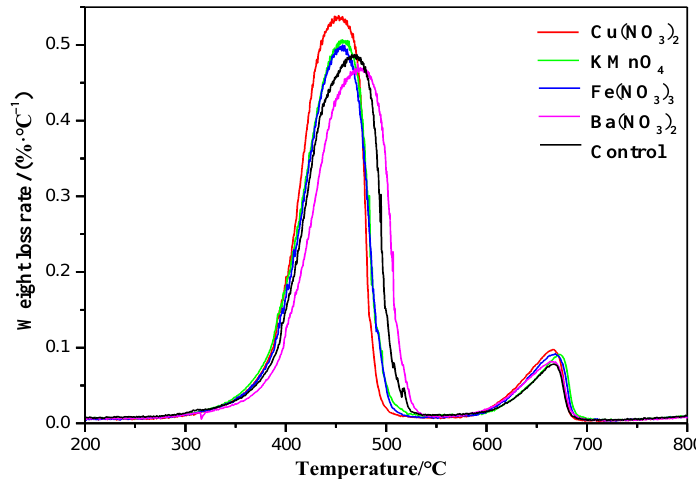
Figure 10. Effect of potential additives on the combustion reactivity of MSW char. To further quantitative evaluation of the effect of different additives on the combus- tion reactivity of MSW char, the ignition temperature, the temperature at maximum weight loss rate, and the maximum weight loss rate are used in this experiment to describe the combustion reactivity of MSW char. The ignition temperature is determined by the intersection method, that is, the point corresponding to the temperature at maximum weight loss rate on the TG curve is drawn as a tangent, and it intersects with the horizontal line where the weight loss begins, and the temperature corresponding to this point is the ignition temperature [31]. Table 4 shows the combustion characteristic parameters of MSW char. After the addition of Cu(NO 3 ) 2 , Fe(NO 3 ) 3 , and KMnO 4, the ignition tempera- tures of MSW char slightly drop. The results could be attributed to the catalytic effect of these additives on the oxidation reaction of MSW char particles [32]. The temperature at the maximum mass loss rate of MSW char is 468.1 °C. The addition of Cu(NO 3 ) 2 , Fe(NO 3 ) 3 , and KMnO 4 significantly reduces the temperature at the maximum mass loss rate of MSW char to 452.7, 454.5, and 459.7 °C, respectively. Simultaneously, the addition of Cu(NO 3 ) 2 , Fe(NO 3 ) 3 , and KMnO 4 increase the maximum mass loss rate. Compared with the maxi- mum weight loss rate (0.49%·°C −1 ) of MSW char without additives, the addition of Cu(NO 3 ) 2 obviously improves the maximum weight loss rate to 0.54% °C −1 . These results confirm that the addition of Cu(NO 3 ) 2 , Fe(NO 3 ) 3 , and KMnO 4 can promote the combustion reactivity of MSW char. However, the addition of Ba(NO 3 ) 2 increases the ignition temper- ature and the temperature at maximum weight loss rate while decreasing the maximum mass loss rate, implying that Ba(NO 3 ) 2 can inhibit the combustion reaction of MSW char. Considering these results from both thermodynamic equilibrium analysis and